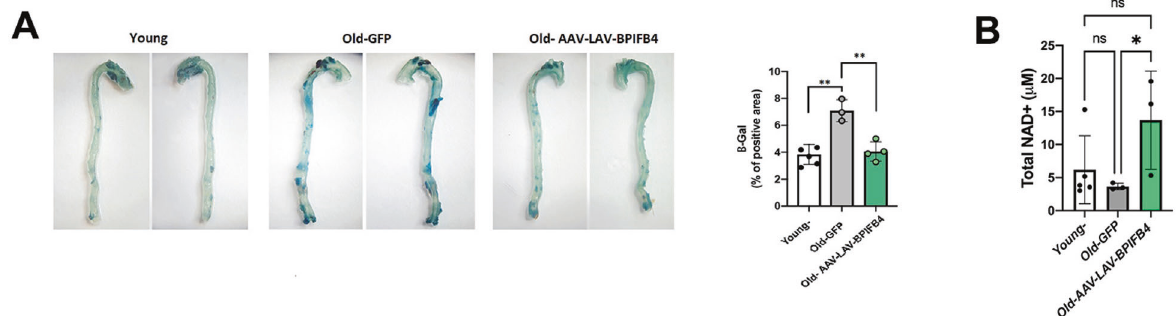
Fig. 2 AAV-LAV-BPIFB4 routes the reduction of senescence in aged-aorta and NAD + plasma levels increase. A Freshly isolated aortas from mice were stained for Sa β -gal. On the left, representative photographs ( n = 2 young, n = 2 Old-GFP, and n = 2 Old-AAV-LAV-BPIFB4 mice ) of Sa β -gal-stained aortas are shown. On the right, the relative densitometric analysis ( n = 5 young mice; n = 3 Old-GFP mice; n = 4 Old-AAV-LAV- BPIFB4 mice) shows the percentage of positive areas. Individual values are expressed as mean ± SD. Pairwise comparisons statistically signi fi cant are indicated (** P < 0.01). Statistical evaluation was carried out by ordinary one-way ANOVA corrected for Dunnett ’ s multiple comparisons test (GraphPad ® Prism). B Bar graph shows the plasmatic levels of total NAD + in n = 5 young mice, n = 3 Old-GFP mice, and n = 3 Old-AAV-LAV-BPIFB4 mice. Results from each treatment group are expressed as mean ± SD. Pairwise comparisons statistically signi fi cant are indicated (* P < 0.05). Statistical evaluation was carried out by ordinary one-way ANOVA and uncorrected Fisher ’ s LSD test for post-hoc analysis (GraphPad ® Prism).